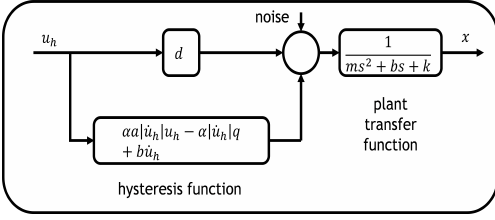
Fig. 3: Mathematical model of piezoelectric bimorph actuator in continuous time. The purposed approach of this project is to continue the modeling of hysteresis